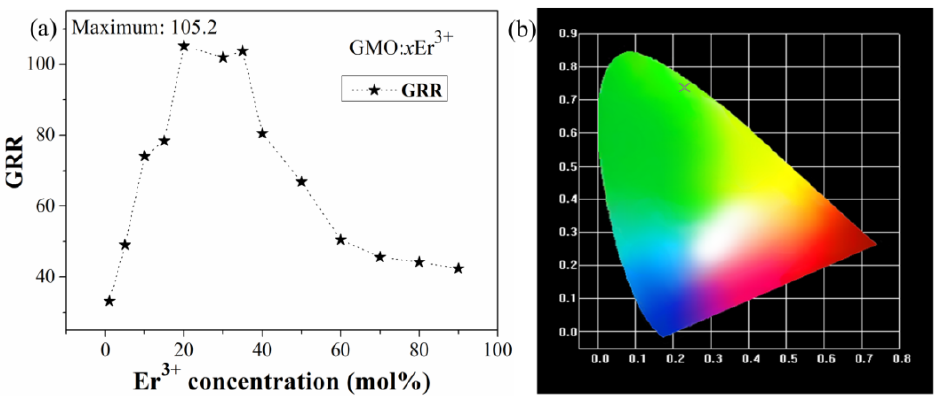
Figure 3. GRR as a function of Er 3+ concentration in Gd 2 (MoO 4 ) 3 : x Er 3+ phosphors ( a ). CIE chromaticity diagram of Gd 2 (MoO 4 ) 3 :20Er 3+ phosphor ( b ).